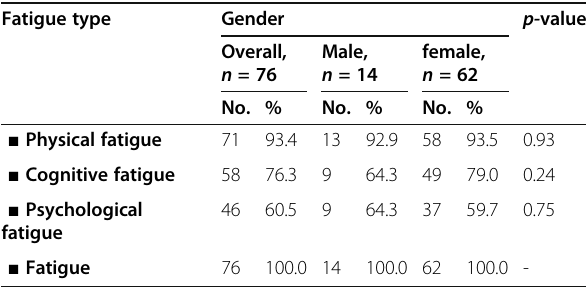
Table 4 Prevalence of physical, cognitive, and psychological fatigue among the studied multiple sclerosis patients at Kasr Al- Ainy Hospital by gender Fatigue type